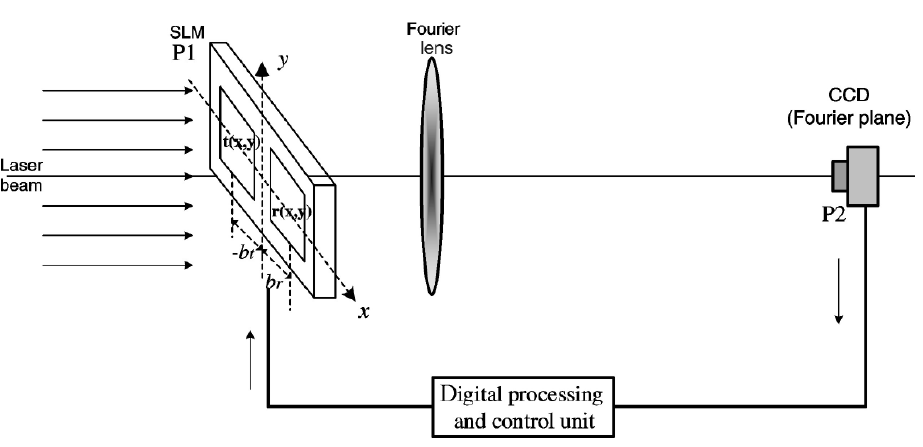
Figure 9. Proposed setup of a compact JTC architecture for spatial applications